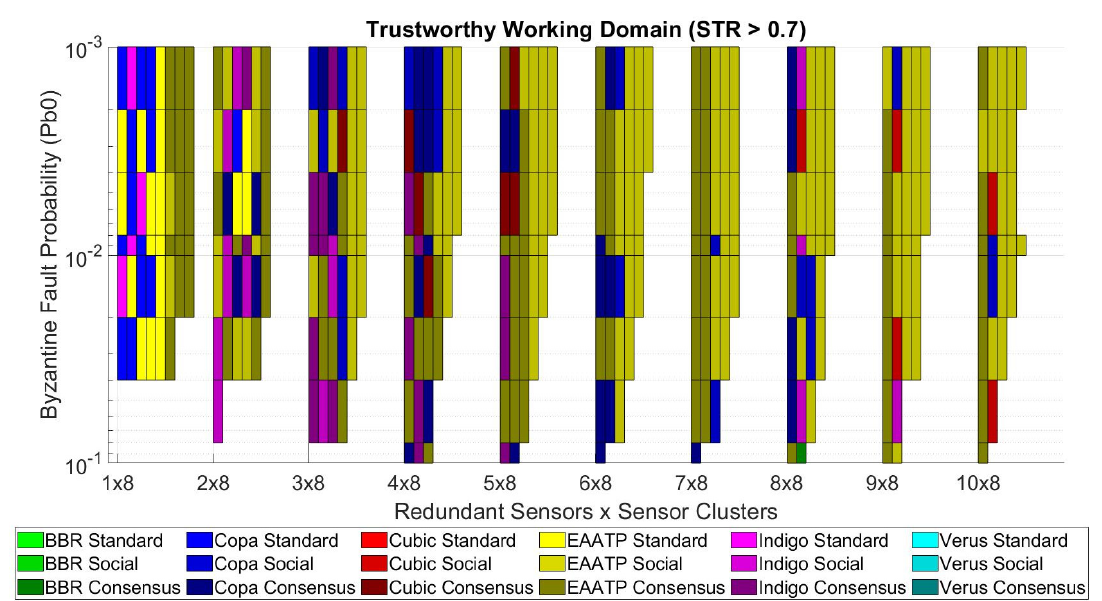
Figure 13. Trustworthiness working domain requiring STR > 0.7.